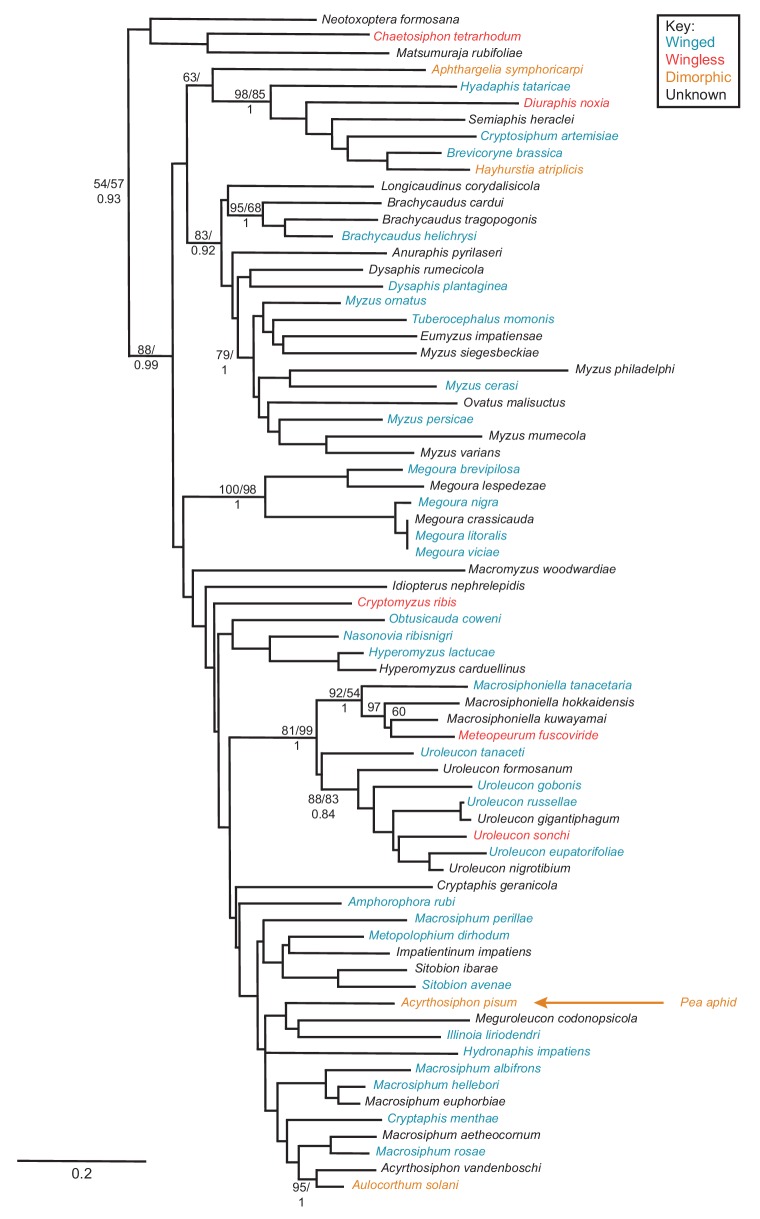
The male wing-dimorphic pea aphid (Acyrthosiphon pisum, arrow) is embedded in a clade of mainly monomorphic winged species.Red species names indicate only wingless males in that species; blue names indicate only winged males in that species; orange names indicate both winged and wingless males in that species; black names indicate lack of phenotype data for that species. Male phenotype was determined from the online resource aphidsonworldsplants.info, which combines information from multiple sources (Blackman and Eastop, 2000; Blackman and Eastop, 1994). Phylogeny is reproduced from Hardy et al. (2015), with their maximum-likelihood and parsimony bootstrap values shown on the left and right of slashes, respectively, and Bayesian posterior probabilities shown below branches.